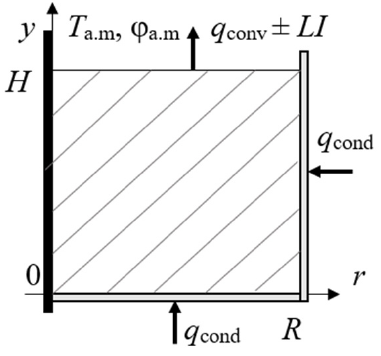
Figure 2. View of the computational domain.